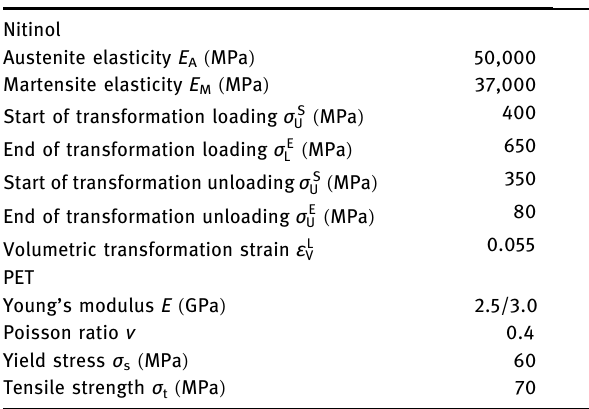
Table 2: Material properties of nitinol and